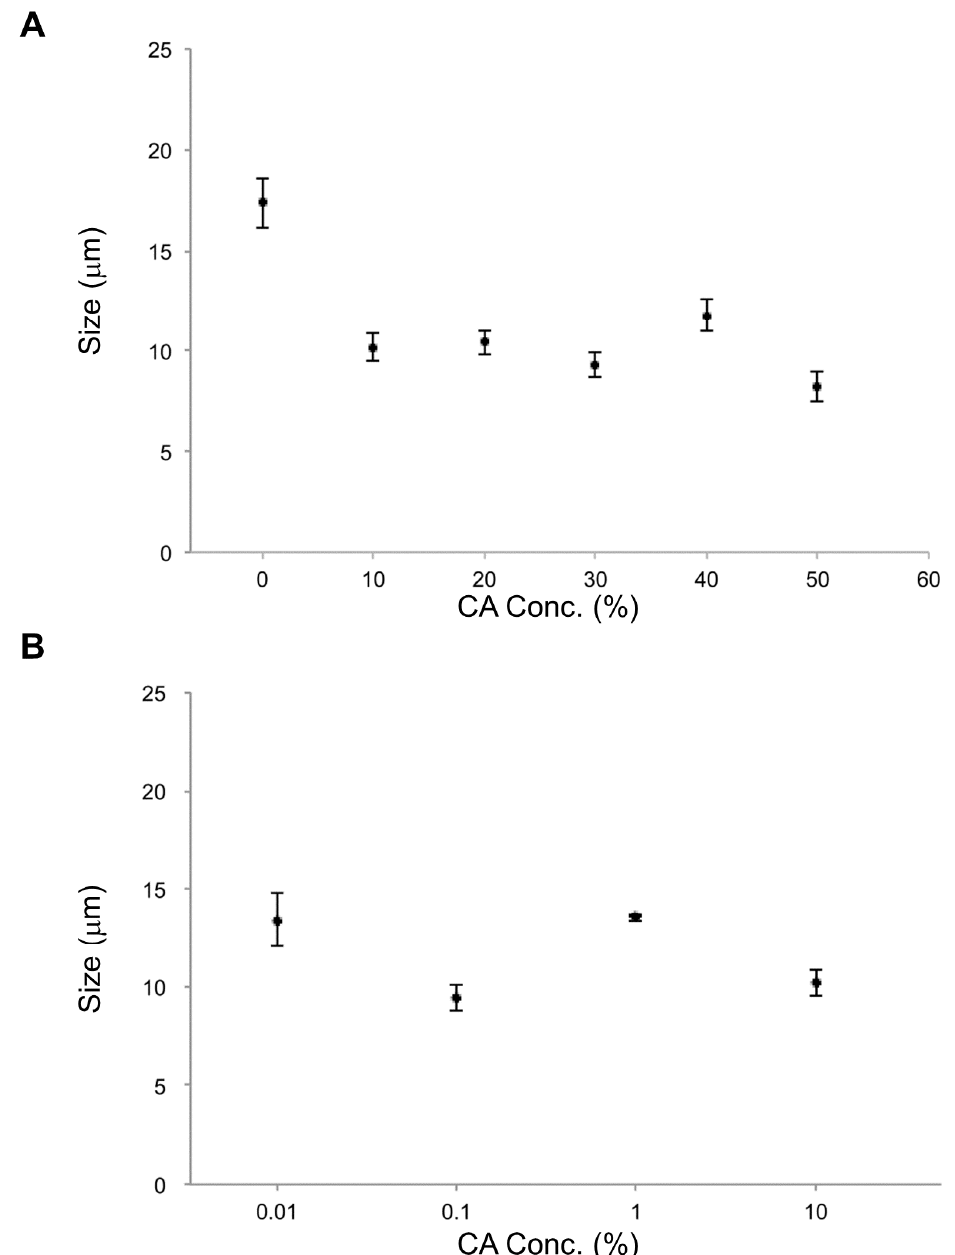
Figure 6. Size of lipid vesicles made from membranes containing caproic acid (CA) at various concentrations: ( A ) 0% to 50%, ( B ) 0.01% to 10%. Standard errors are shown as error bars.